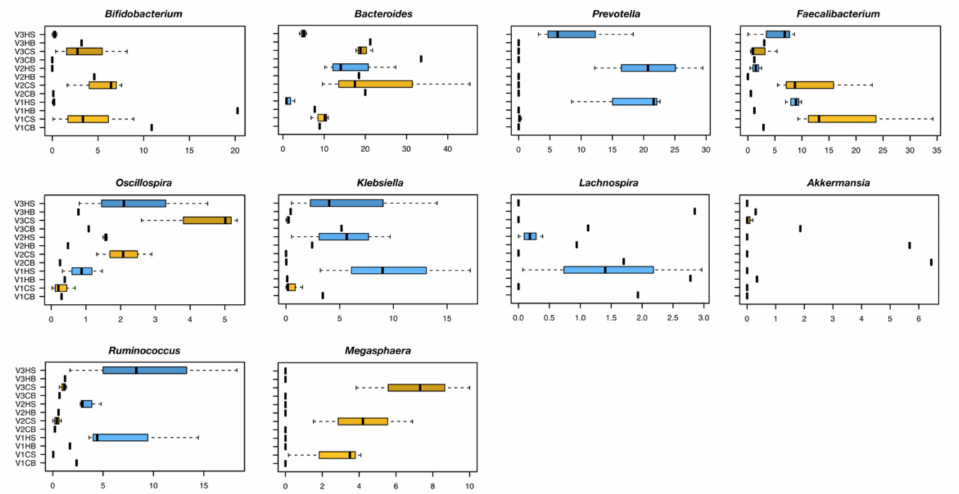
Figure 2. Genus-level differences in the faecal-derived microbial communities between the Coeliac ( n = 1) and healthy donor ( n = 1) following fermentation with C. pyrenoidosa extract (Sun Chlorella‘A’ Powder). Boxplots showing the relative abundance distribution of bacterial genera differentially represented among the study groups (vessels (V) 1, 2 and 3, inoculated with faeces from Coeliac (C) vs. healthy (H) donor, at baseline (B) and steady state (S) after addition of C. pyrenoidosa extract (Sun Chlorella ‘A’ Powder). ( p ≤ 0.1, Kruskal − Wallis